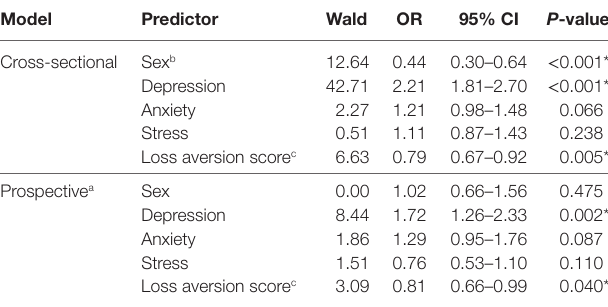
a The prospective model controlled for the effect of experimental condition. b In sex, female sex constitutes the reference category. c Higher loss aversion scores indicates a greater aversion to losses. *Sig. at P < 0.05, one-sided.